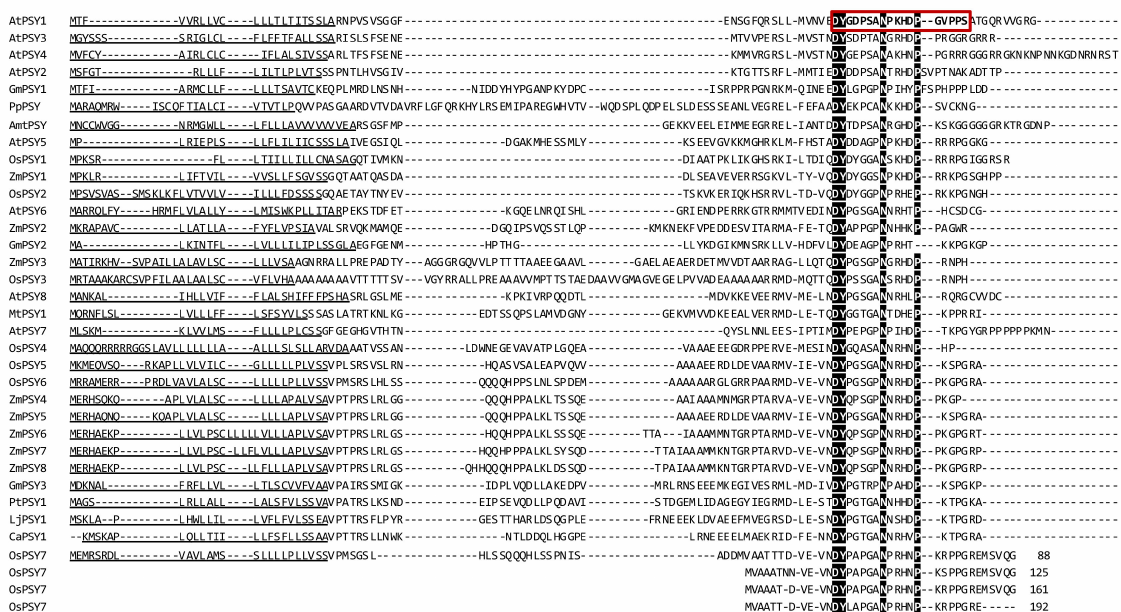
Figure 3. Alignment of a selection of PSY homologs in different plant species and mosses based on translated complementary DNA sequences. Amino acid sequences for the PSY homologs are from Arabidopsis thaliana (AtPSY); Amborella trichopoda (AmtPSY); rice, Oryza sativa (OsPSY); maize, Zea mays (ZmPSY); soybean, Glycine max (GmPSY); chickpea, Cicer arietinum (CaPSY); Lotus japonica (LjPSY); Populus trichocarpa (PtPSY); Medicago truncatula (MtPSY) and Physcomitrella patens (PpPSY). OsPSY7 which includes four copies of the mature peptide is found at the bottom of the alignment arranged to highlight the repeated sequence. The positions in the sequence are included. The red box and letters in bold indicate mature PSY1. Black boxes indicate conserved amino acid residue. Underlined amino acids are predicted secretion signal